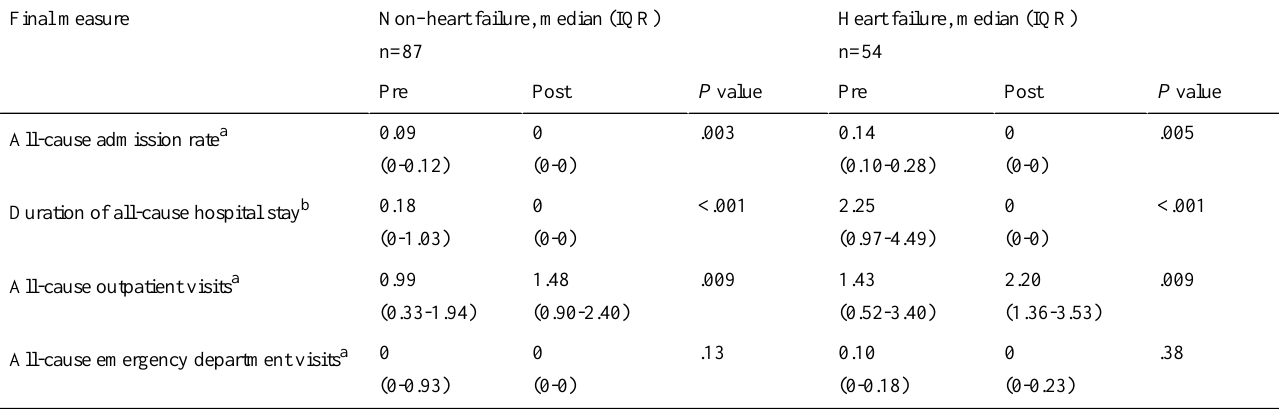
Table 3. Differences in admission rates and duration of hospital stays 6 months before (pre) and 6 months after (post) initiation of telehealth services in patients with cardiovascular diseases, stratified according to heart failure